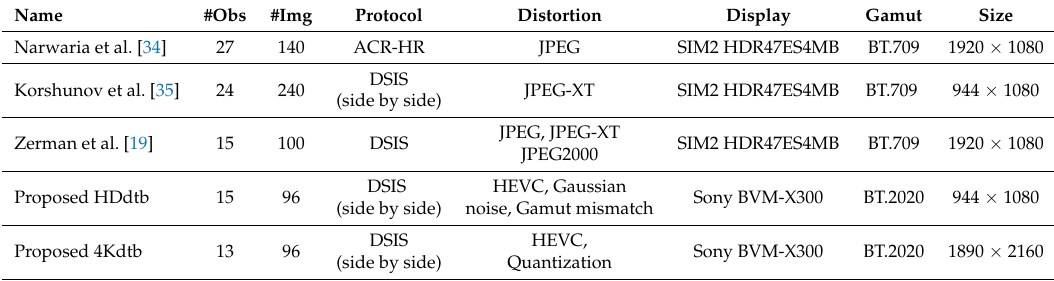
Table 2. Number of observers, number of images, subjective test protocol, kind of distortion and used display for the 3 existing HDR image quality databases and the two databases proposed in this paper.